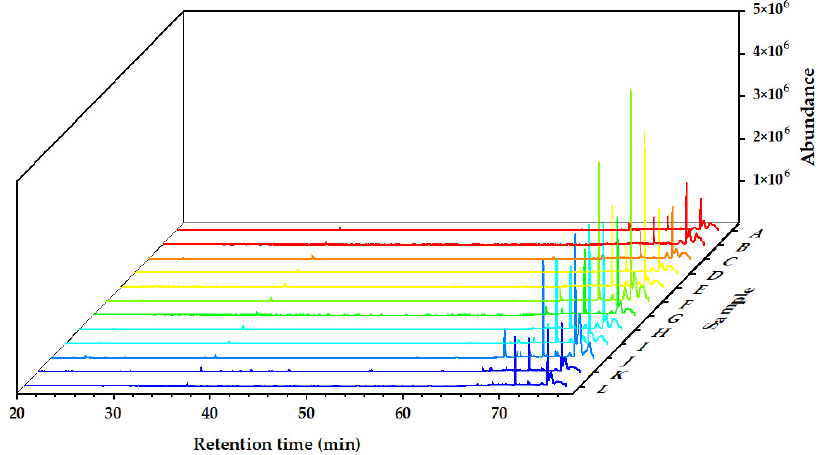
Figure 2. GC-MS chromatograms of the volatile components of the ethanol extractives of Alnus cremastogyne pods.